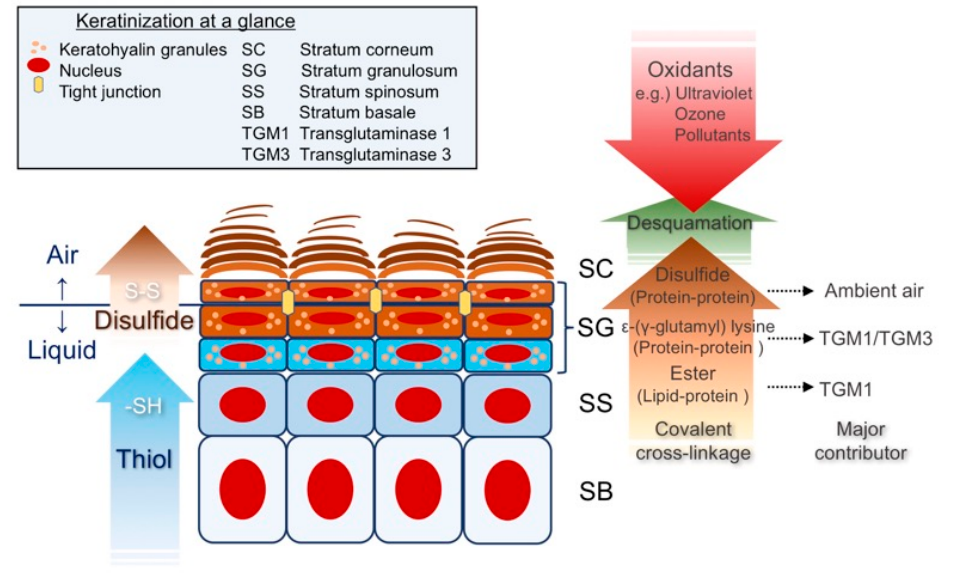
Figure 1. Keratinization at a glance. A thiol (-SH) gradient through the epidermis provides unparalleled cytoprotection. Following a microenvironmental rise in Ca 2 + , TGMs catalyze ε -( γ -glutamyl) lysine (protein-protein) cross-linkages and ester (lipid-protein) cross-linkages above the SS. Upon exposure to the ambient air, the keratinocyte cytoskeleton undergoes extensive disulfide formation in the SG and stabilizes corneocytes.